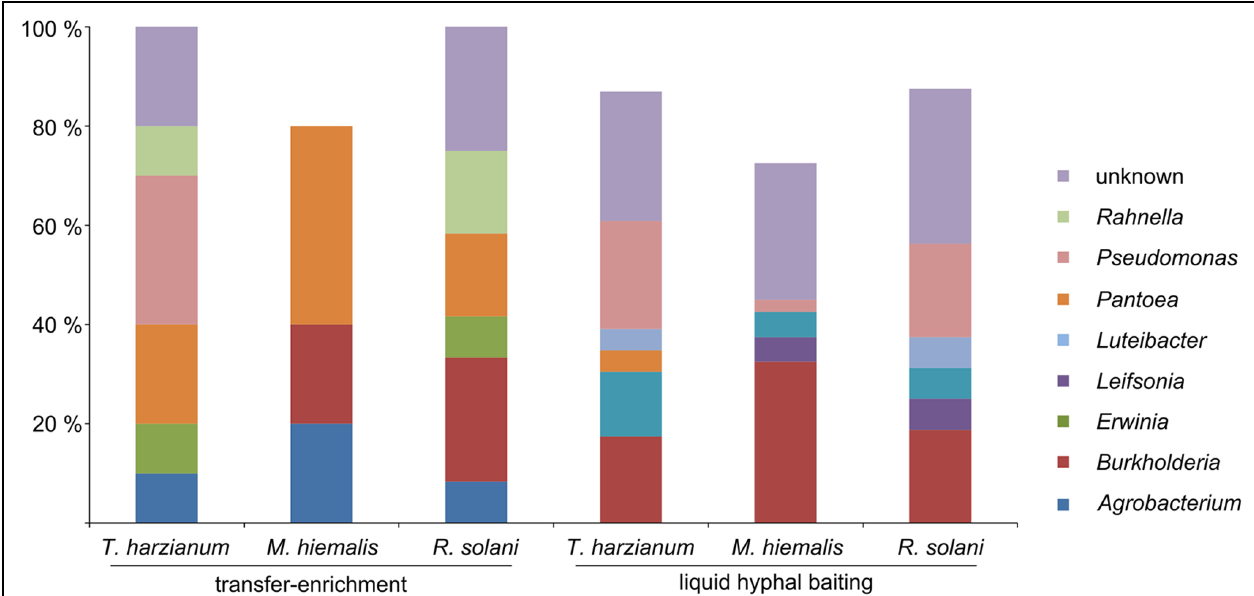
FIGURE 2 | Relative amount of antifungal, hyphae-adhering bacterial isolates grouped by bacterial genus, the three host fungi ( T. harzianum, M. hiemalis, R. solani ) and the two isolation methods (long-term baiting “transfer-enrichment” and short-term “liquid hyphal-baiting”. Only genera are displayed of which isolates were obtained that colonized more than one fungal species or that were isolated with both